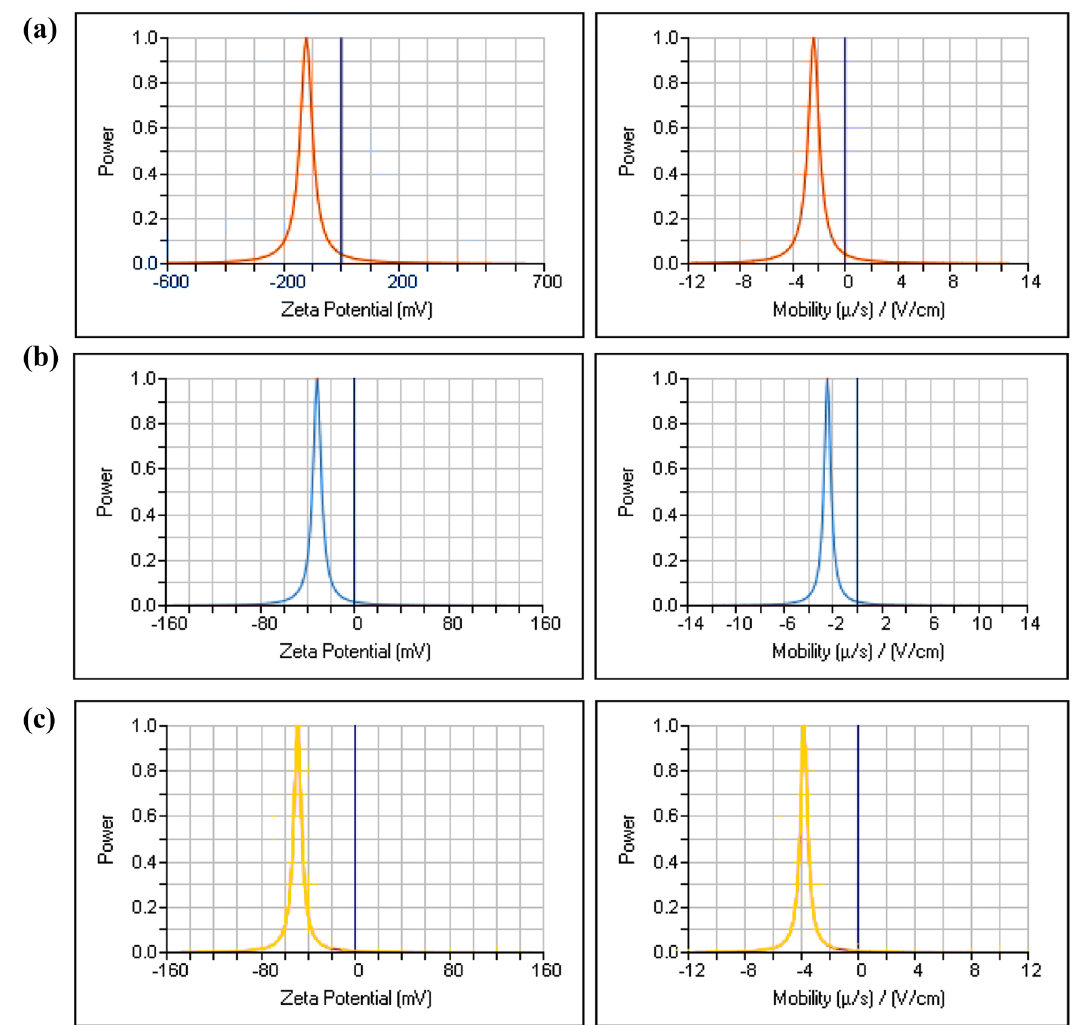
Figure 7: The ζ - potentials: ( a ) CHR, ( b ) AuNPs, and ( c ) CHR – AuNPs.